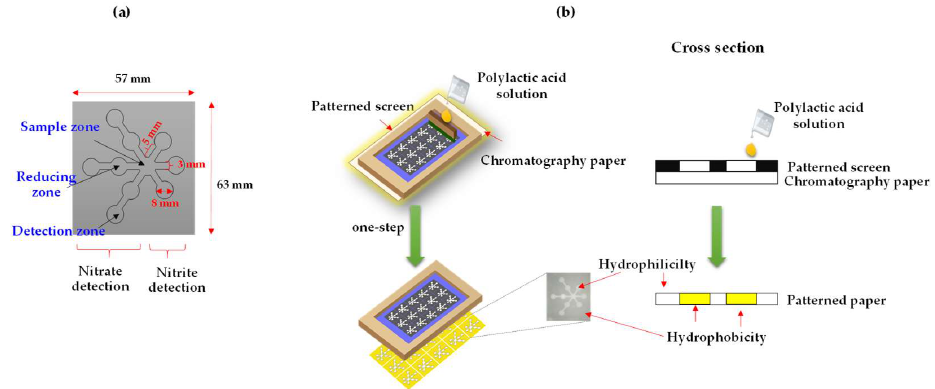
Figure 1. μPAD design for simultaneous detection of nitrite and nitrate ( a ) and a schematic diagram of the screen-printing process for μPAD fabrication using polylactic acid ( b ).